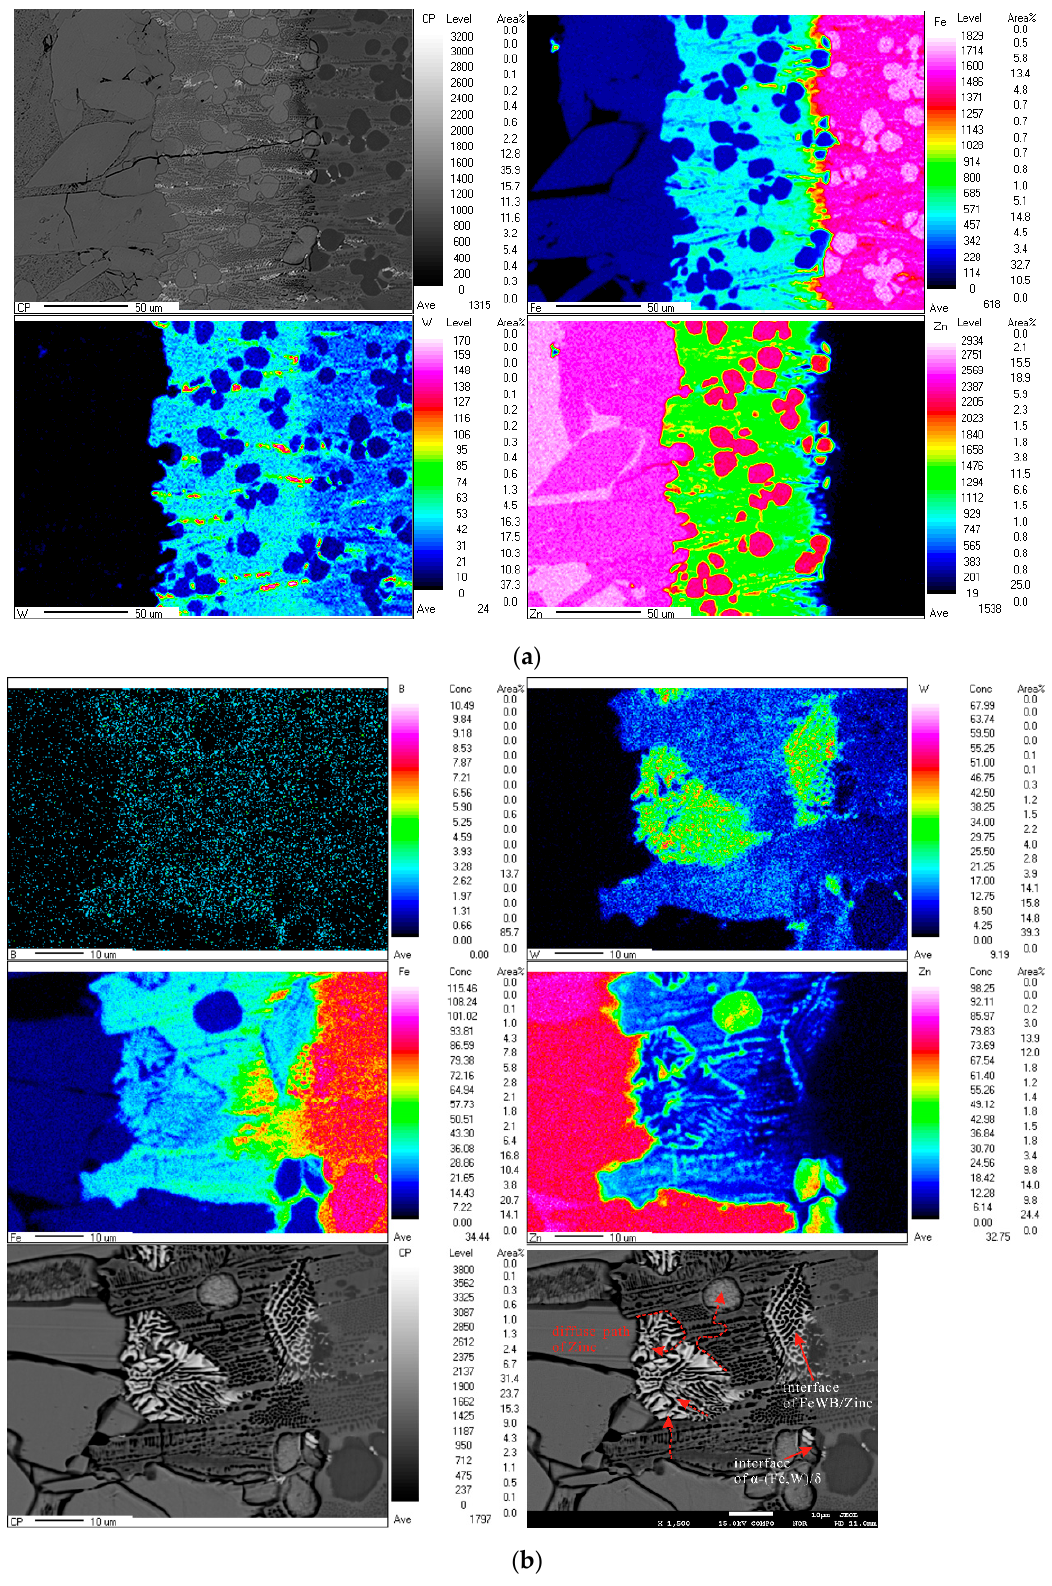
Figure 7. Element EPMA mapping of corrosion layer for alloy A5 ( a ) and A7 ( b ).